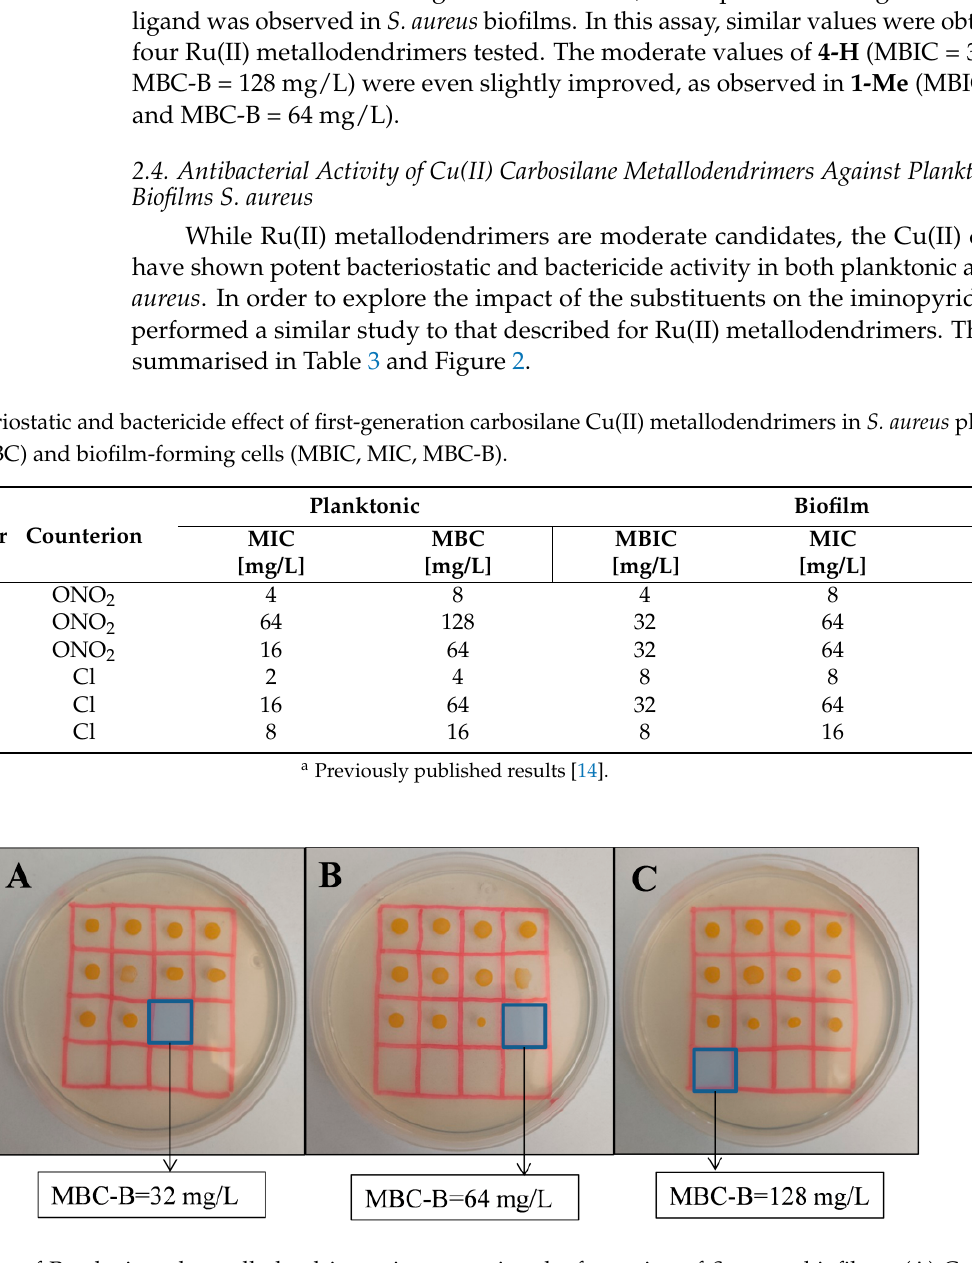
Figure 2. Effect of R-substituted metallodendrimers in preventing the formation of S. aureus biofilms. ( A ) Compound 3-OMe , with Cu(II) chloride complex; ( B ) compounds 2-OMe and 1-Me , with Cu(II) nitrate and Ru(II) cymene complexes, respectively; and ( C ) compounds 2-Me , 3-Me and 1-OMe , with Cu(II) nitrate, Cu(II) chloride and Ru(II) cymene complexes, respectively. The minimum bactericidal concentration for biofilms (MBC-B) represents the minimal concentration of the metallodendrimer that can kill the microorganism in the conditions used to produce a biofilm.